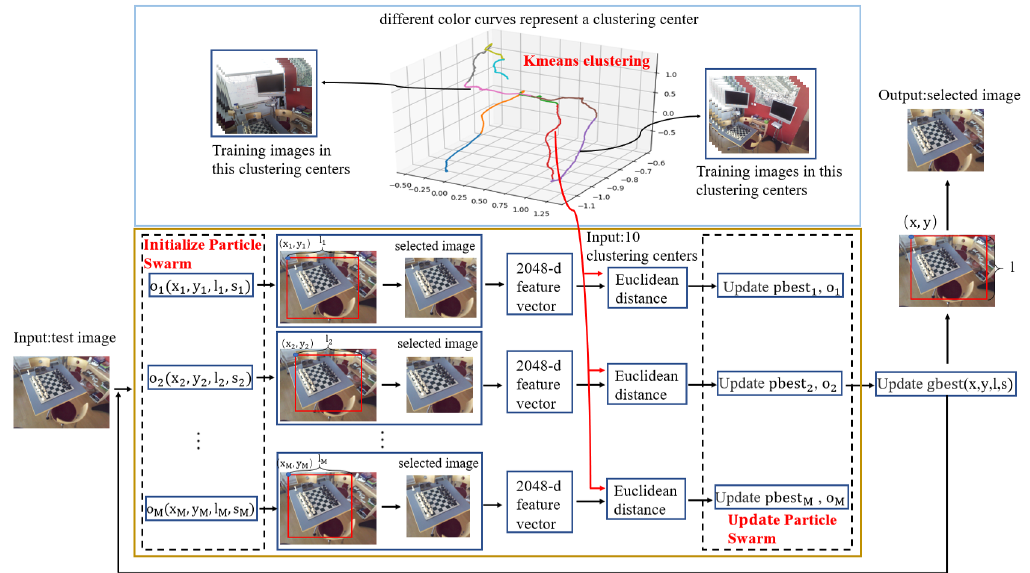
Figure 3. The flow block diagram of the PSO-based image-block selection algorithm. Using this method, the image which is most similar to the training set can be